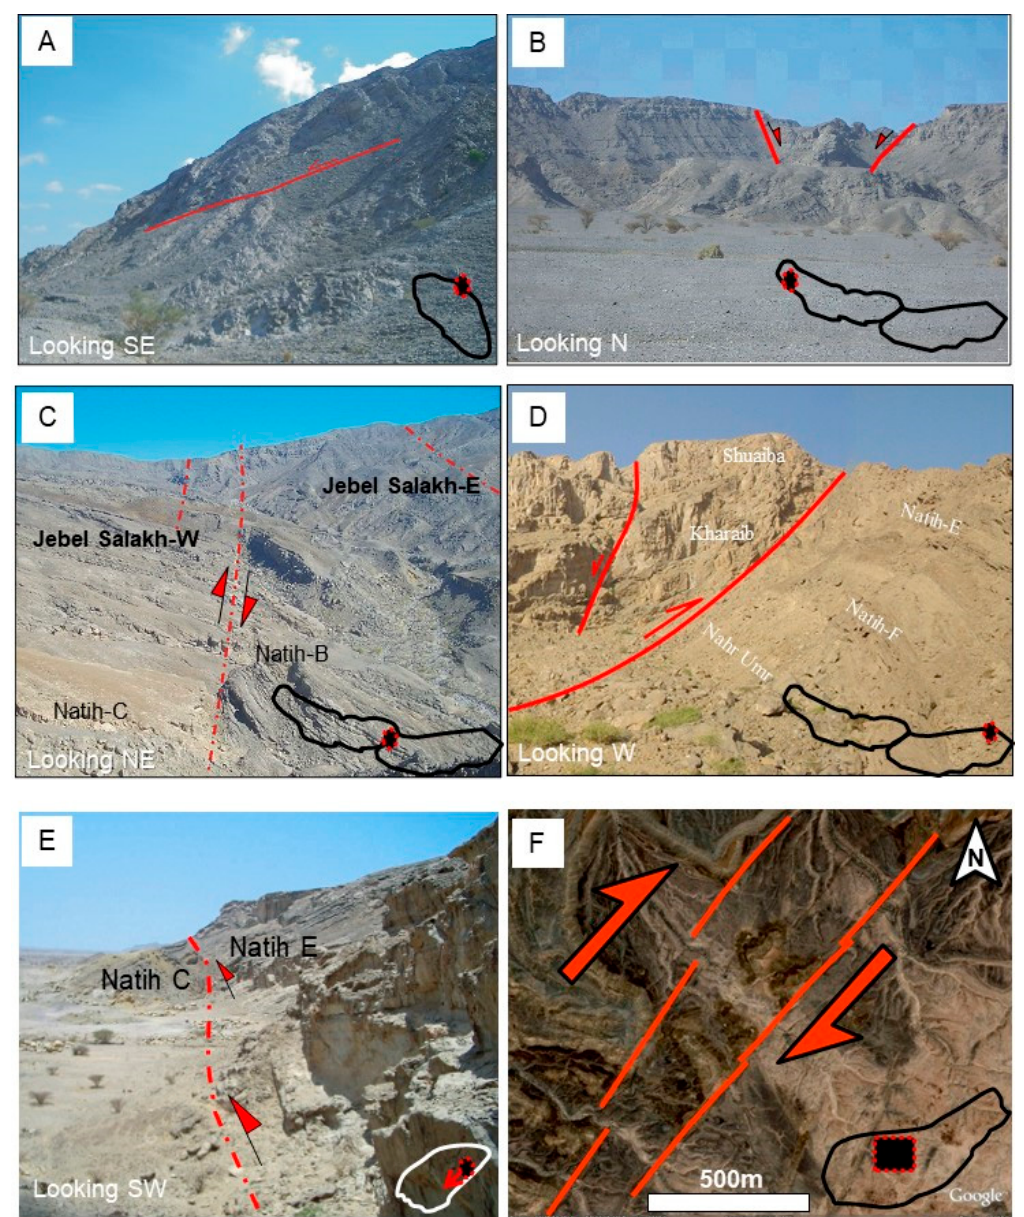
Figure 8. ( A ) a thrust plane in the northern flank of Jebel Nahdah, close to the northern-bounding thrust, plausibly tilted by the folding process. Note that the fault currently looks like having a normal sense of movement. ( B ) A graben structure in the western part of Salakh W formed by fold-axis parallel extension, ( C ) a strike-slip fault zone separating the structures of the Salakh E from Salakh W, ( D ) a thrust in the northern flank of Jebel Salakh E, ( E ) a major thrust in the southern flank of Jebel Hinaydi, ( F ) a map view of the NE-SW fault zone in Jebel Madmar. The faults are transtentional and the stepping of their trajectories indicate dextral lateral